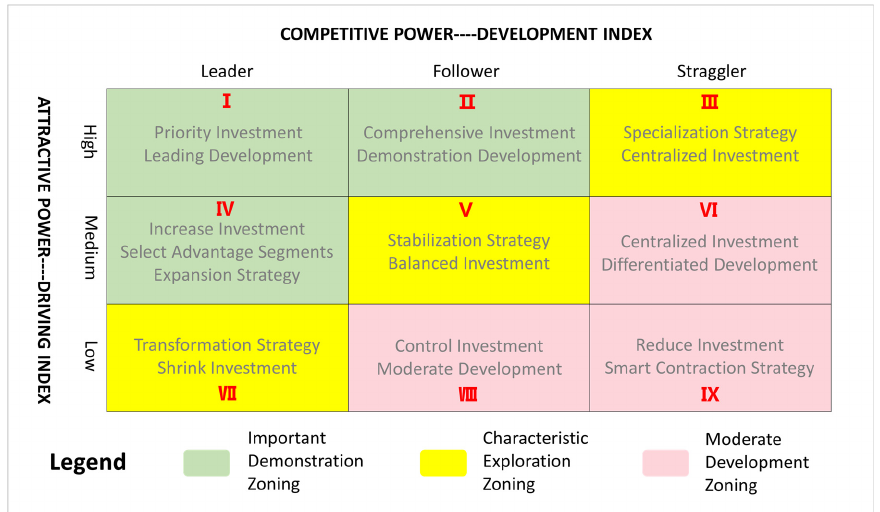
Figure 5. general matrix